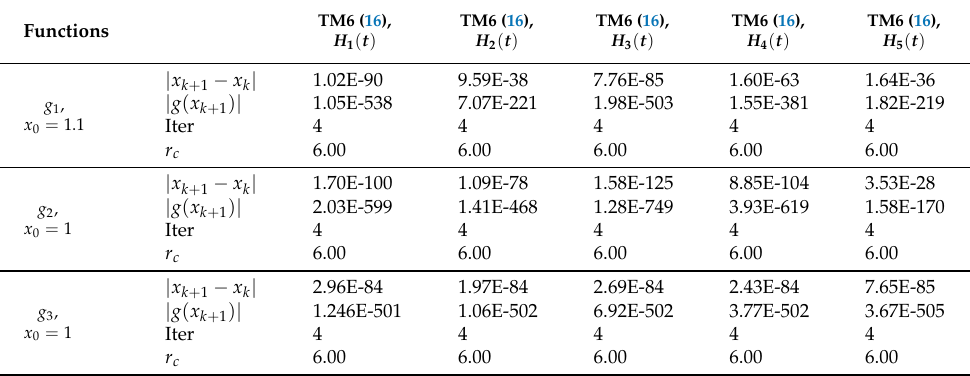
Table 3. Comparison of various iterative schemes (third part).